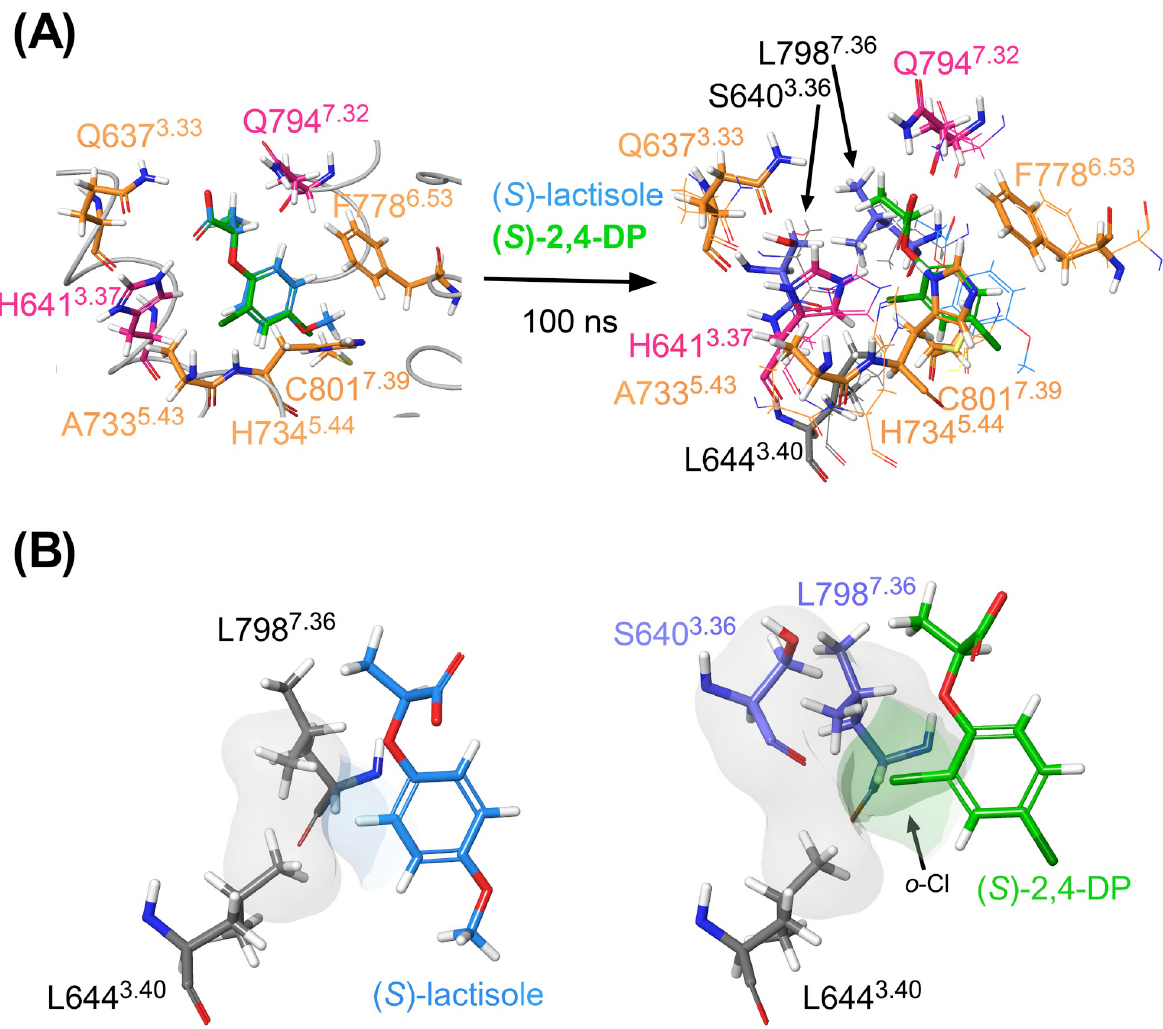
Fig 3. Comparison of the results of MD minimizations for ( S )-lactisole and ( S )-2,4-DP. (A) Results of the MD minimization of ( S )-lactisole (shown in blue) and ( S )-2,4-DP (shown in green). In the superimposed view after MD minimization, the ( S )-lactisole model is shown by thin lines, and the ( S )-2,4-DP model is shown by thick lines. (B) Van der Waals interaction areas between T1R3-TMD and ( S )-lactisole or ( S )-2,4-DP are